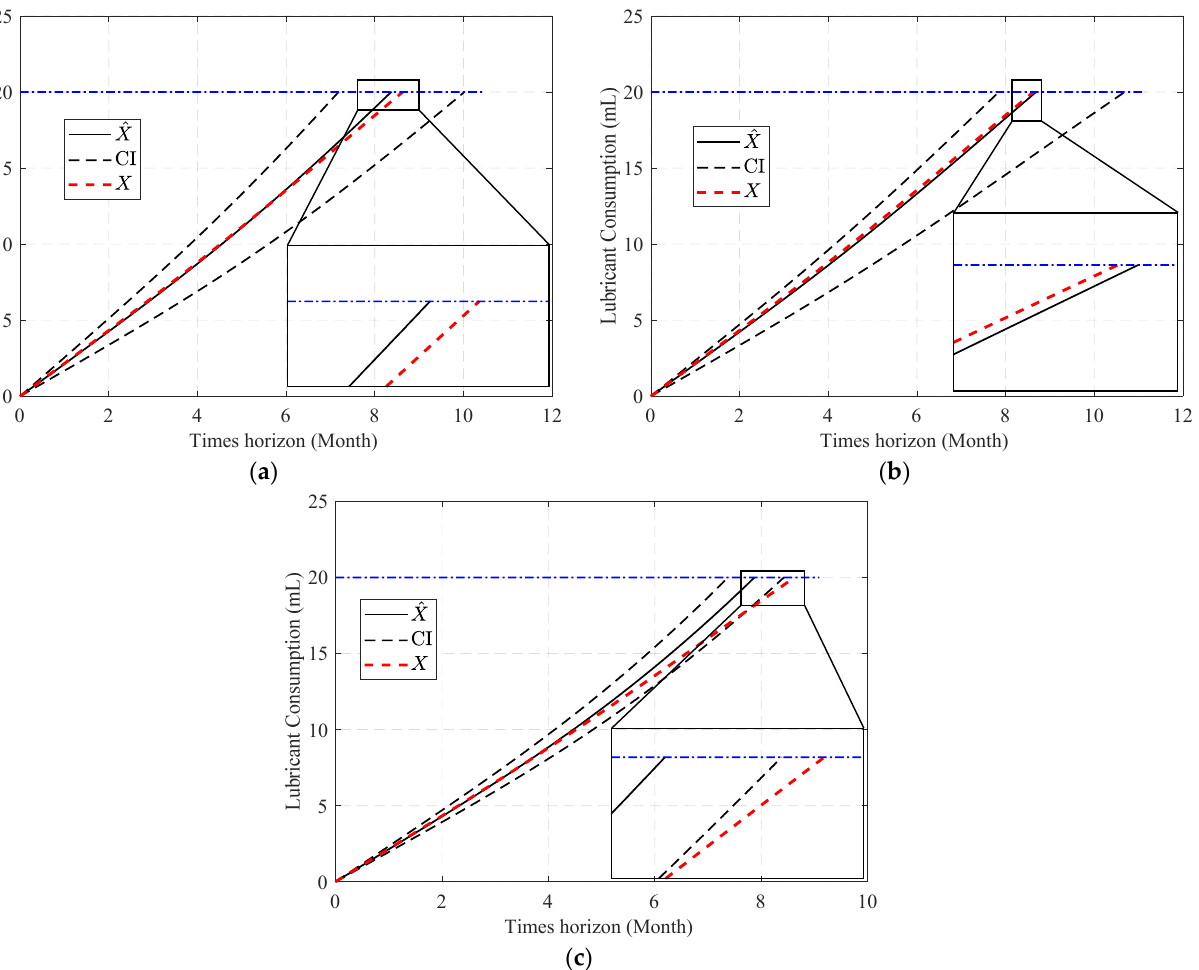
Figure 21. Failure prognosis results (second fault scenario): ( a ) using PF for temperature estimation and the two-step method for parameter estimation; ( b ) using APF for temperature estimation and the two-step method for parameter estimation; and ( c ) using APF for temperature estimation and the one-step method for parameter estimation.